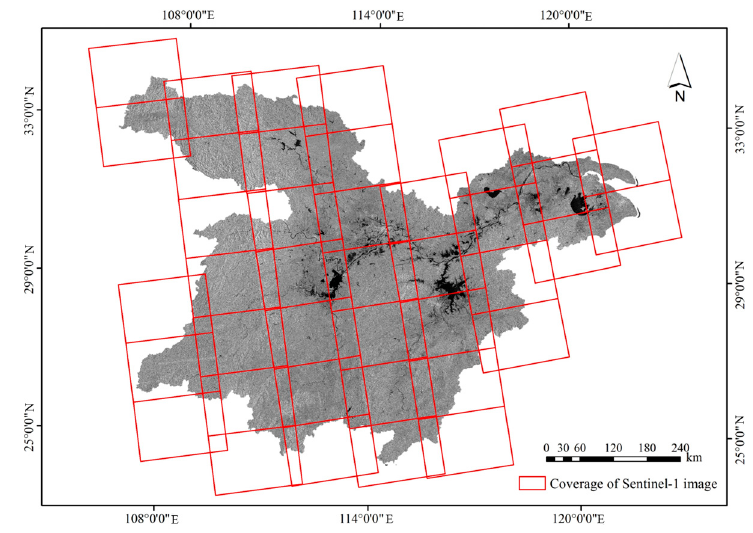
Figure 2. The geographic coverage of Sentinel-1 images in the study area.